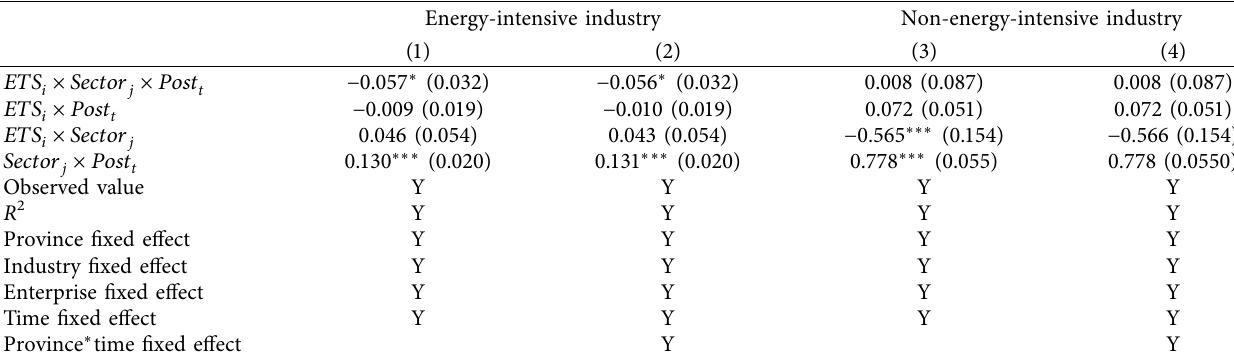
Table 5: Heterogeneity analysis of considering energy-intensive